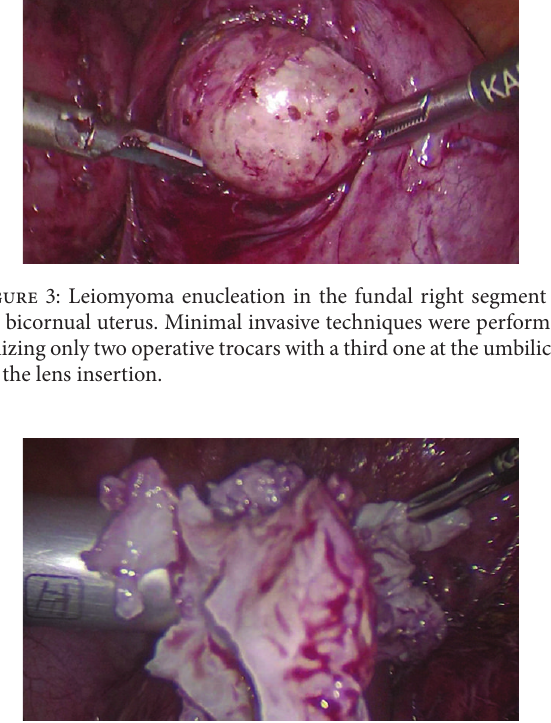
Figure 4: Power morcellation was employed to remove a total of 3 fibroids; the total morcellated leiomyoma mass was 101 g. Lack of such a crucial instrument would deprive patients like this one of benefiting from